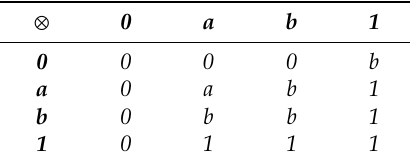
Table 11. The operation ⊗ on X .